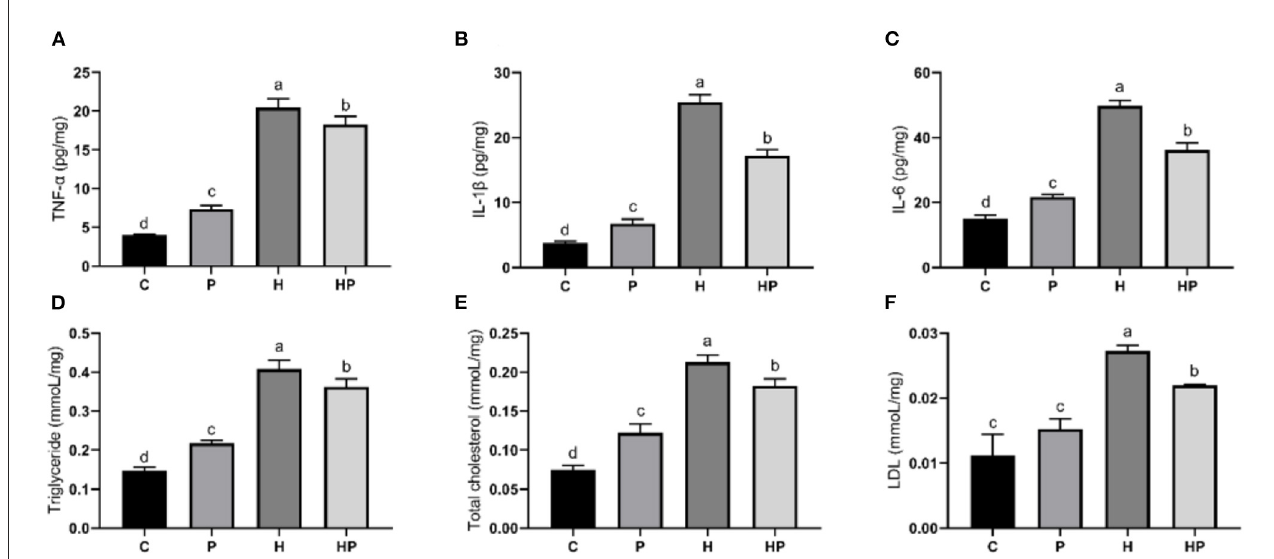
FIGURE8 Effect of P. pentosaceus PR-1 on liver pro-inflammatory cytokines (A–C) and biochemical parameters (D–F) in HFD-fed zebrafish. (A) Hepatic concentration of tumor necrosis factor α (TNF- α ). (B) Hepatic concentration of interleukin-1ß (IL-1ß). (C) Hepatic concentration of interleukin-6 (IL-6).